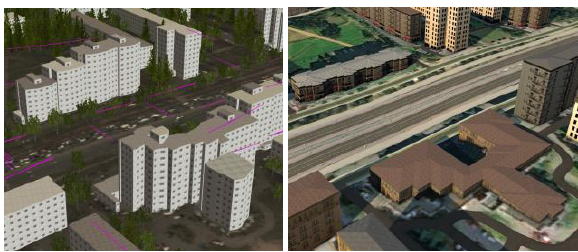
Figure 10. Building height difference between lidar-based model (left) and InfraWorks (right)